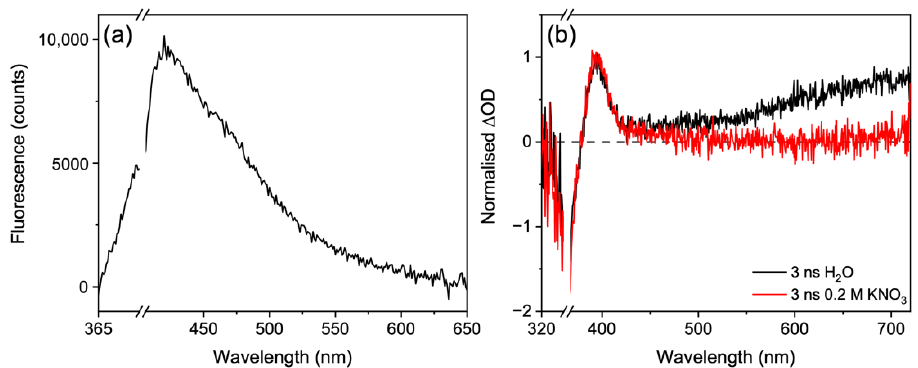
Figure 4. ( a ) Fluorescence spectra of a ~1 µ M usujirene/palythene aqueous solution. ( b ) TAS taken at 3 ns of usujirene/palythene in water (black) and in 0.2 M KNO 3 (red).